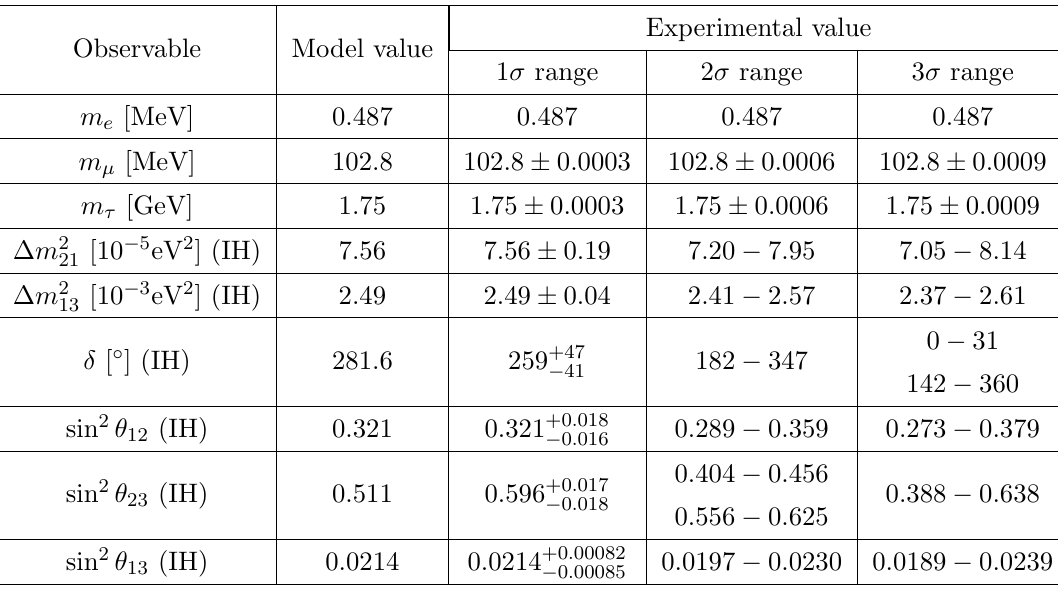
Table 4 . Model and experimental values of the charged lepton masses, neutrino mass squared splittings and leptonic mixing parameters for the inverted (IH) mass hierarchy. The model values for CP violating phase are also shown. The experimental values of the charged lepton masses are taken from ref. [57], whereas the range for experimental values of neutrino mass squared splittings and leptonic mixing parameters, are taken from ref. [61].